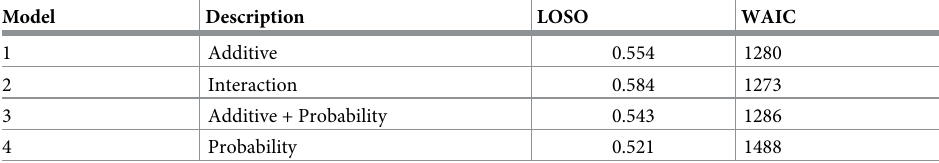
Table 3. Model comparison for SGTs. The most parsimonious model accounts for data through adding distance and vehicular guidability features, and their multiplicative interaction. I-scores were explicative of distance sensitivities, but only in high influence